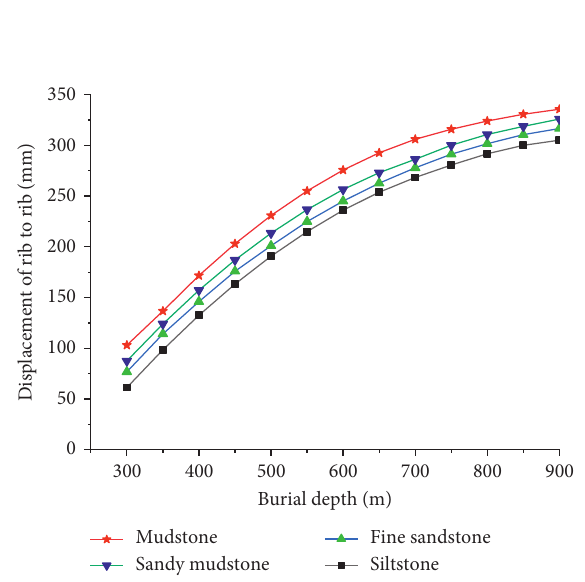
Figure 30: Displacement of roof to floor. Figure 31: Displacement of